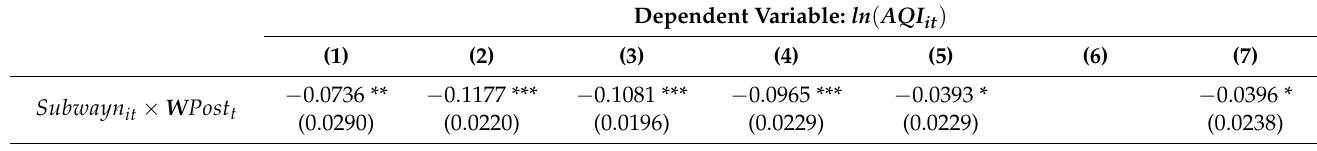
Table 4. Estimation results based on difference-in-differences analysis (DID).